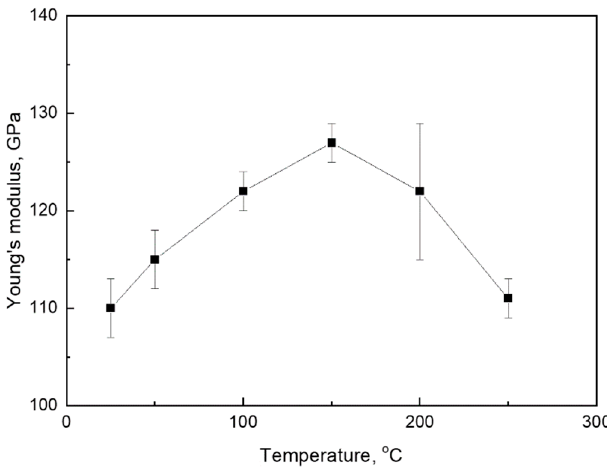
Figure 12. Temperature dependence of Young’s modulus of the Fe ‐ 30Mn ‐ 5Si alloy (HR 800 ).